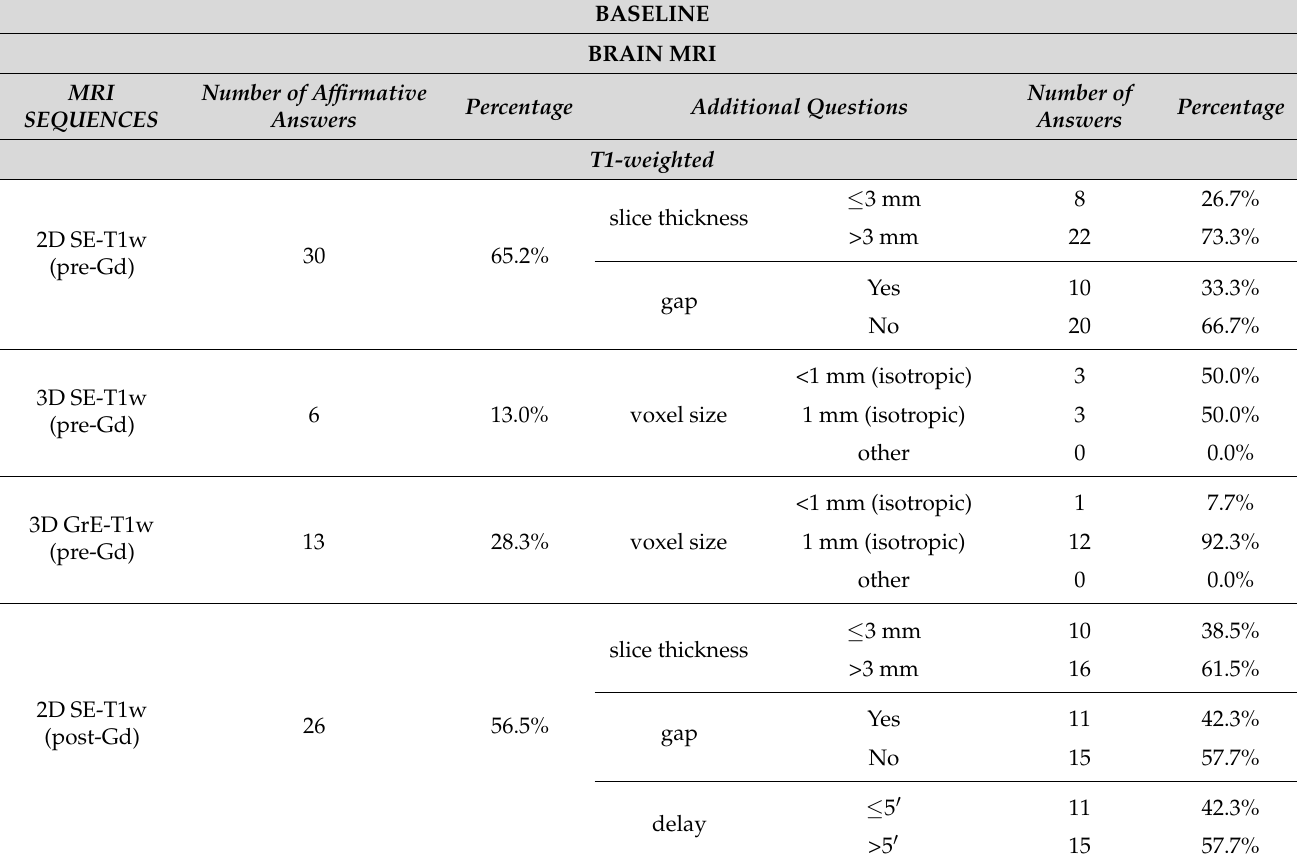
Table 1. Results of the survey regarding brain and spine MRI at